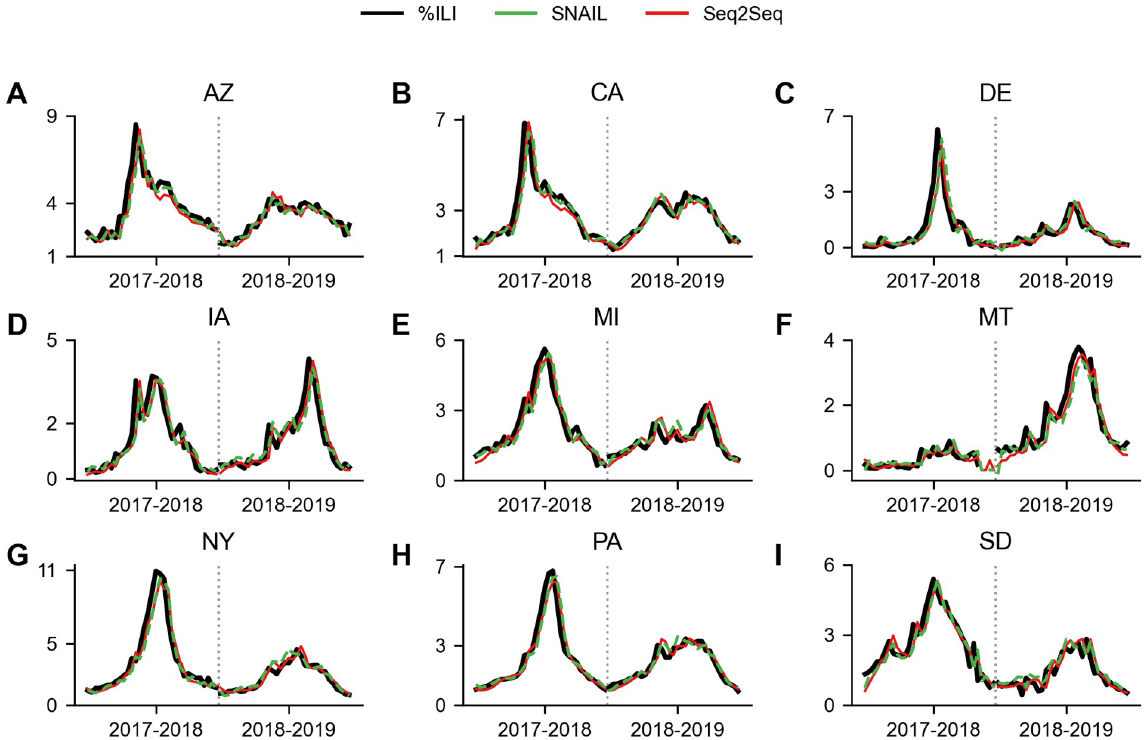
Fig 15. Example plots of %ILI in 9 states {AZ, CA, DE, IA, MA, MT, NY, PA, SD} and predictions made by SNAIL and Seq2Seq for two seasons 2017–2018 (validation) and 2018–2019 (test). A. Arizona, B. California, C. Delaware, D. Iowa, E. Massachusetts, F. Montana, G. New York, H. Pennsylvania, and I. South Dakota. The original %ILI is depicted in solid black lines and the prediction results of SNAIL and Seq2Seq are depicted in dashed green lines and solid red lines.